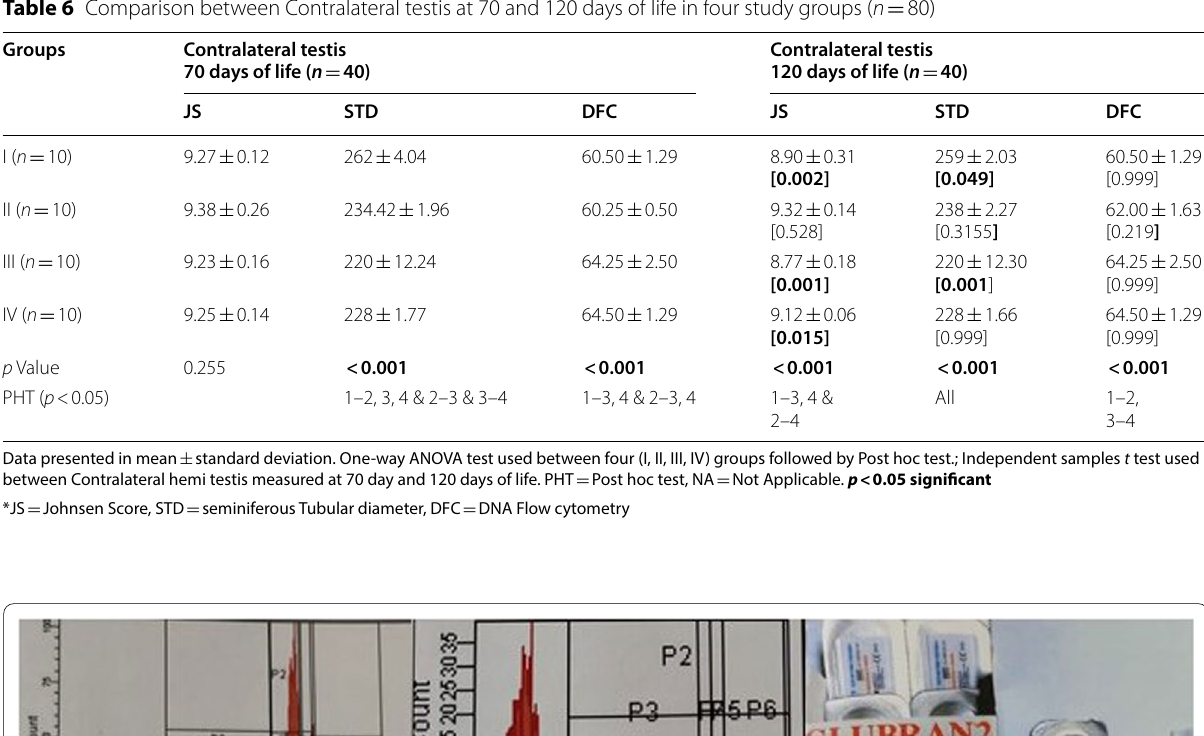
Table 6 Comparison between Contralateral testis at 70 and 120 days of life in four study groups ( n